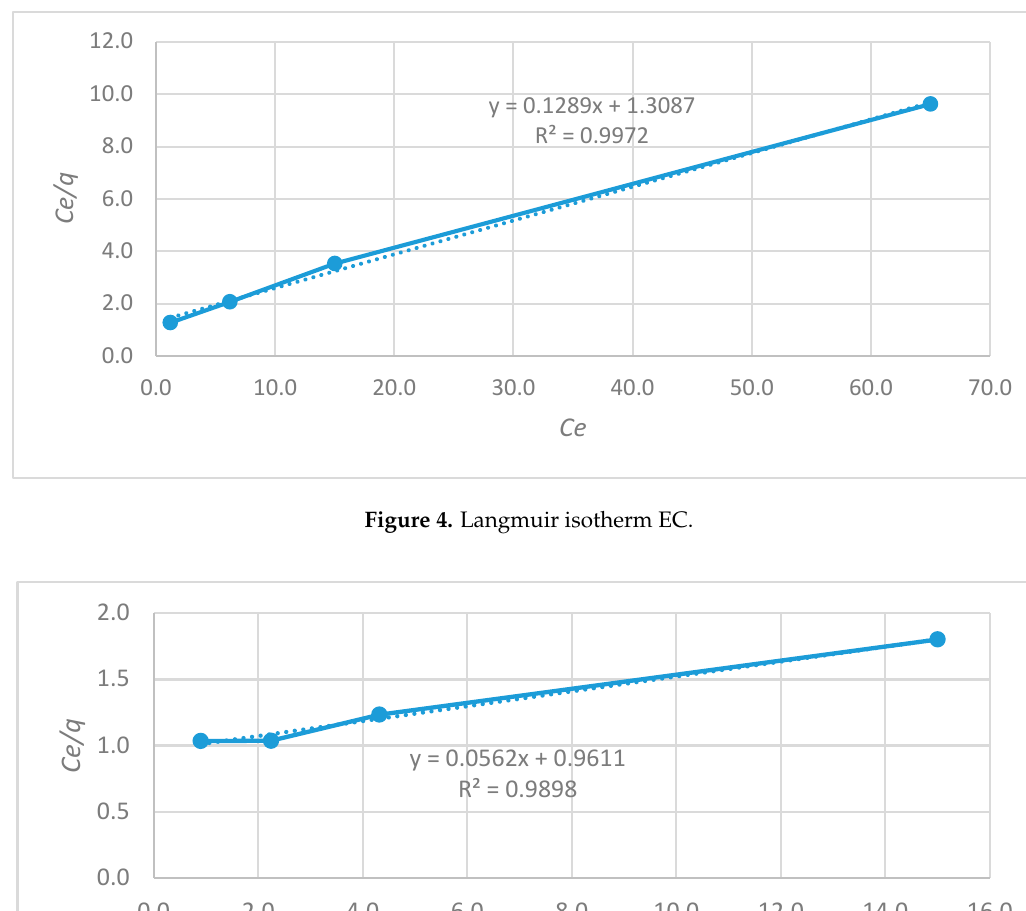
Figure 4. Langmuir isotherm EC.